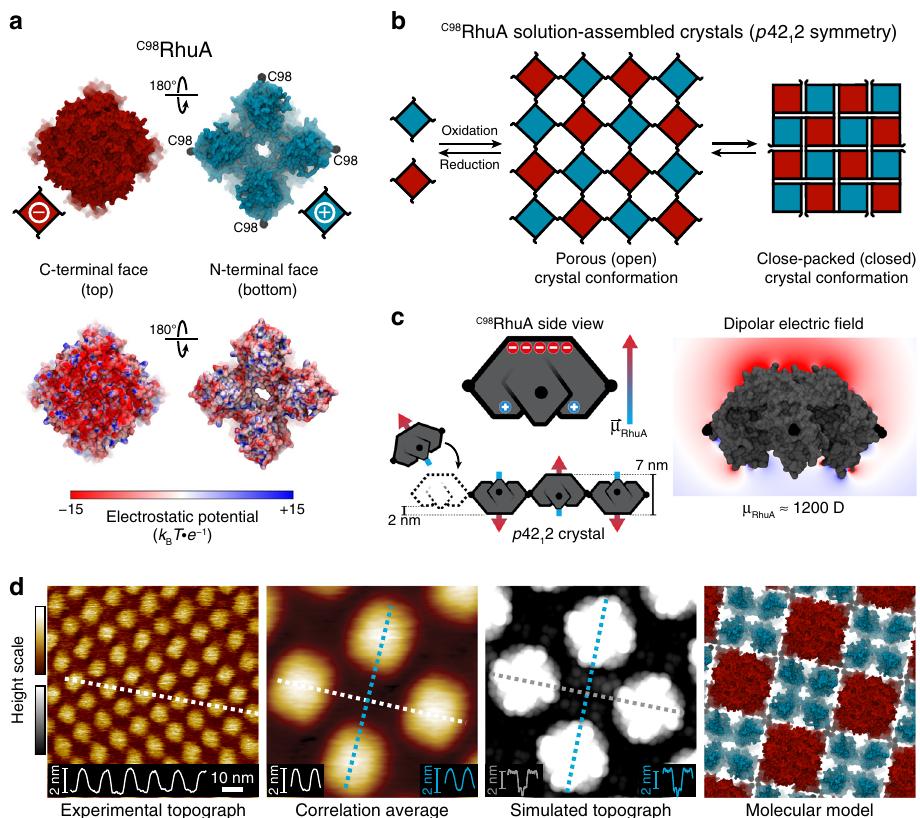
Fig. 1 Solution self-assembly of C98 RhuA. a Solvent-excluded surfaces and electrostatic potential maps of C98 RhuA termini faces, colored according to charge. Depth cueing is used to highlight the two distinct topographies of each terminus. C98 residues are shown as black spheres. b Schematic depicting C98 RhuA solution self-assembly into 2D p 42 C98 RhuA macrodipole moment and its global- 1 2 crystals and their emergent auxetic behavior. c Origin of the scale electric fi eld (red to blue color range: − 7.5 to + 2.5 k B T ∙ e − 1 ). Cartoon arrows represent the dipole orientation of each protein. d High-resolution AFM topographs and corresponding structural model of solution-assembled close-packed crystals. The height pro fi les correspond to the dashed lines. Height ranges (gradient): 5 nm (experimental), 2 nm